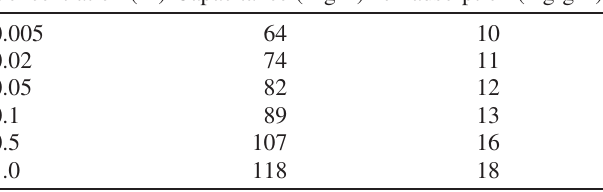
TABLE V. Electrode capacitance (in F g − 1 ) and ion adsorption for a symmetric electrochemical cell under a voltage of 1.0 V, using the modified Donnan model with parameters fitted to reproduce our MD simulation results for the capacitance at high concentration (see Table II). Results for ion adsorption are given as the total mass of ions inside both electrodes, per unit mass of both electrodes [see Eq.